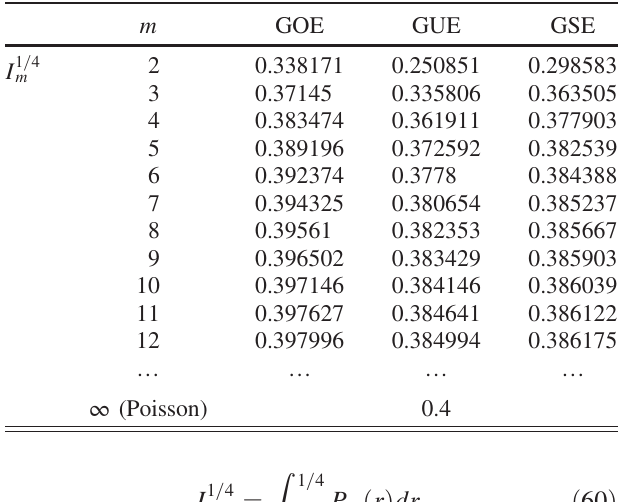
TABLE III. Value of I 1 = 4 m defined by Eq. (60) obtained from the surmise approach in Sec. III.